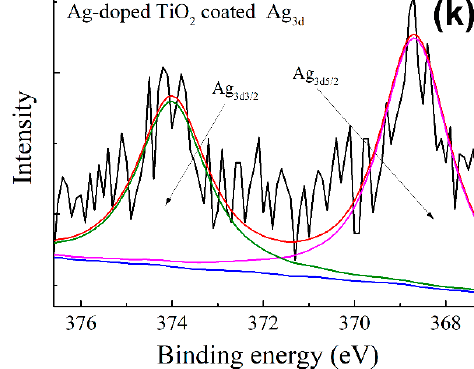
Figure 4. The ( a ) survey spectra for the P–1, P–2, TiO 2 coated and Ag-doped TiO 2 coated filaments, ( b ) O 1s and ( c ) Ti 2p core-level deconvolution spectra of the P–1 filaments, ( d ) O 1s , ( e ) Ti 2p and ( f ) Ag 3d core-level deconvolution spectra of the P–2 filaments; ( g ) O 1s and ( h ) Ti 2p core-level deconvolution spectra of the TiO 2 coated filaments, ( i ) O 1s , ( j ) Ti 2p and ( k ) Ag 3d core-level deconvolution spectra of the Ag-doped TiO 2 coated filaments Table 1. The results of X-ray photoelectron spectroscopy (XPS) elemental analysis of the P–1, P–2, TiO 2 coated and Ag-doped TiO 2 coated filaments. PET Filaments Peak Binding Energy (eV) FWHM (eV) Area (Cps • eV)